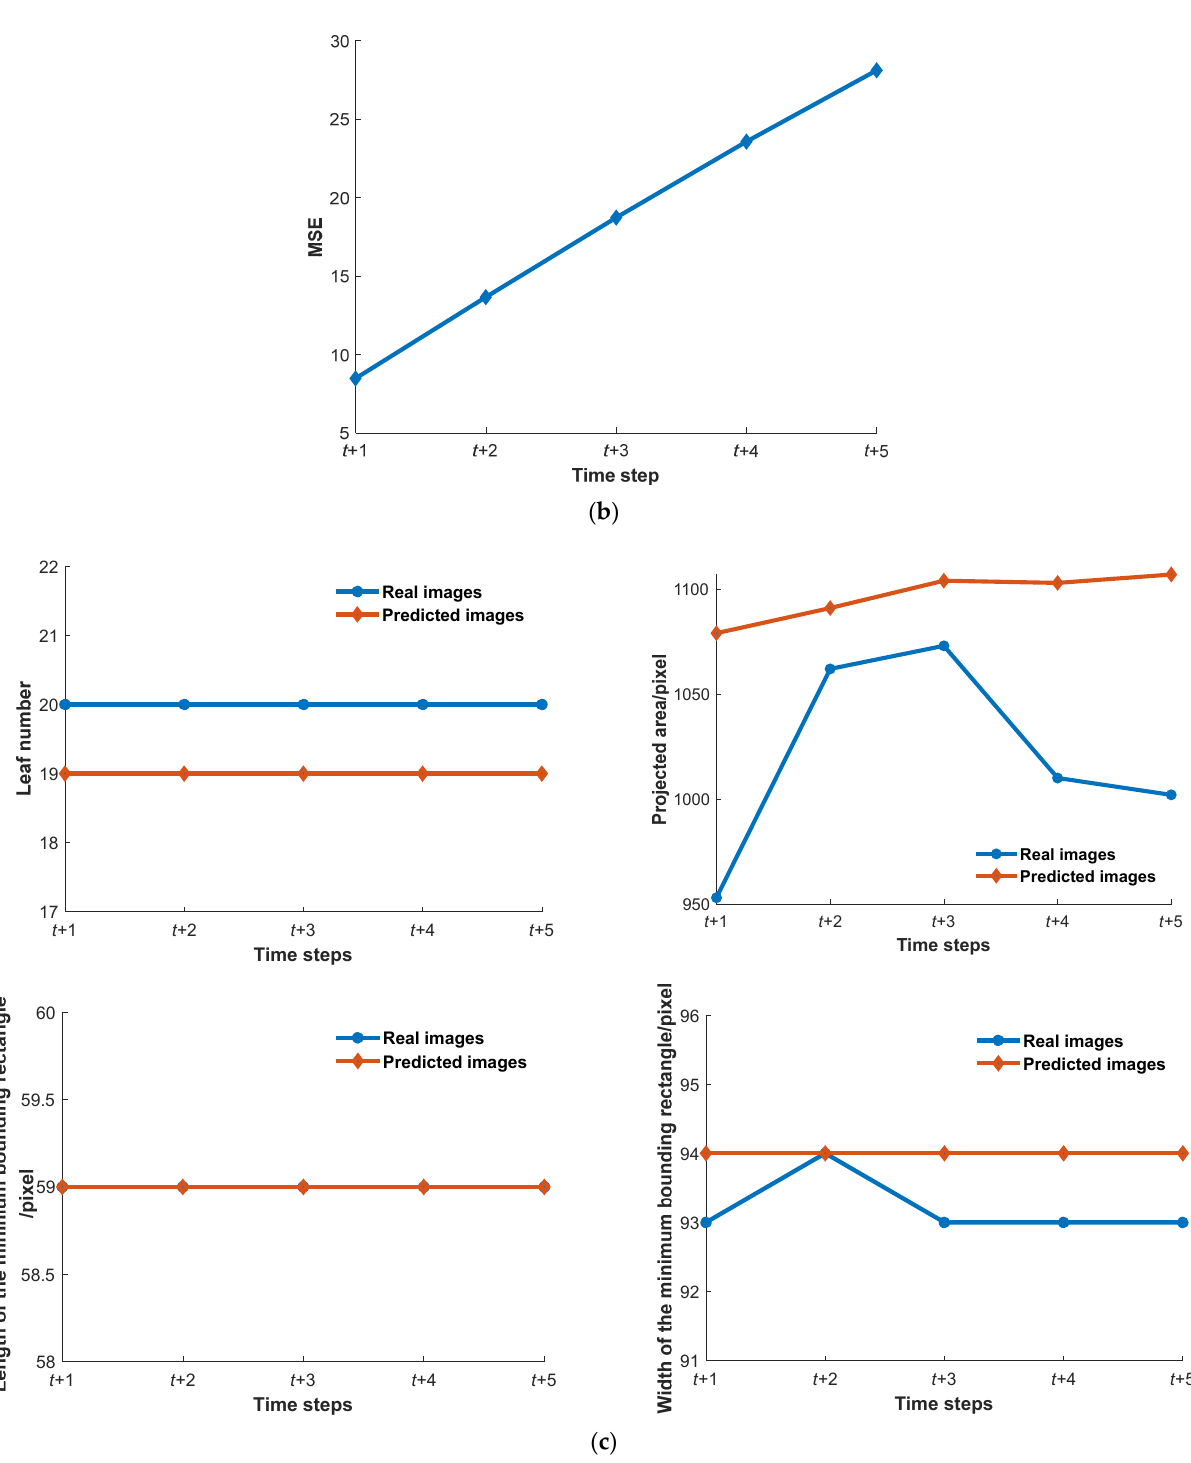
Figure 5. Samples of the results predicted by the proposed prediction model on the successive-view wheat dataset. ( a ) Comparison between the predicted images and the real images of future growth and development. ( b ) Average evaluation results of MSE, PSNR, and SSIM at each time step from t + 1 to t + 5. ( c ) Comparison of leaf number, projected area, length of the minimum bounding rectangle, and width of the minimum bounding rectangle between the predicted and real images.